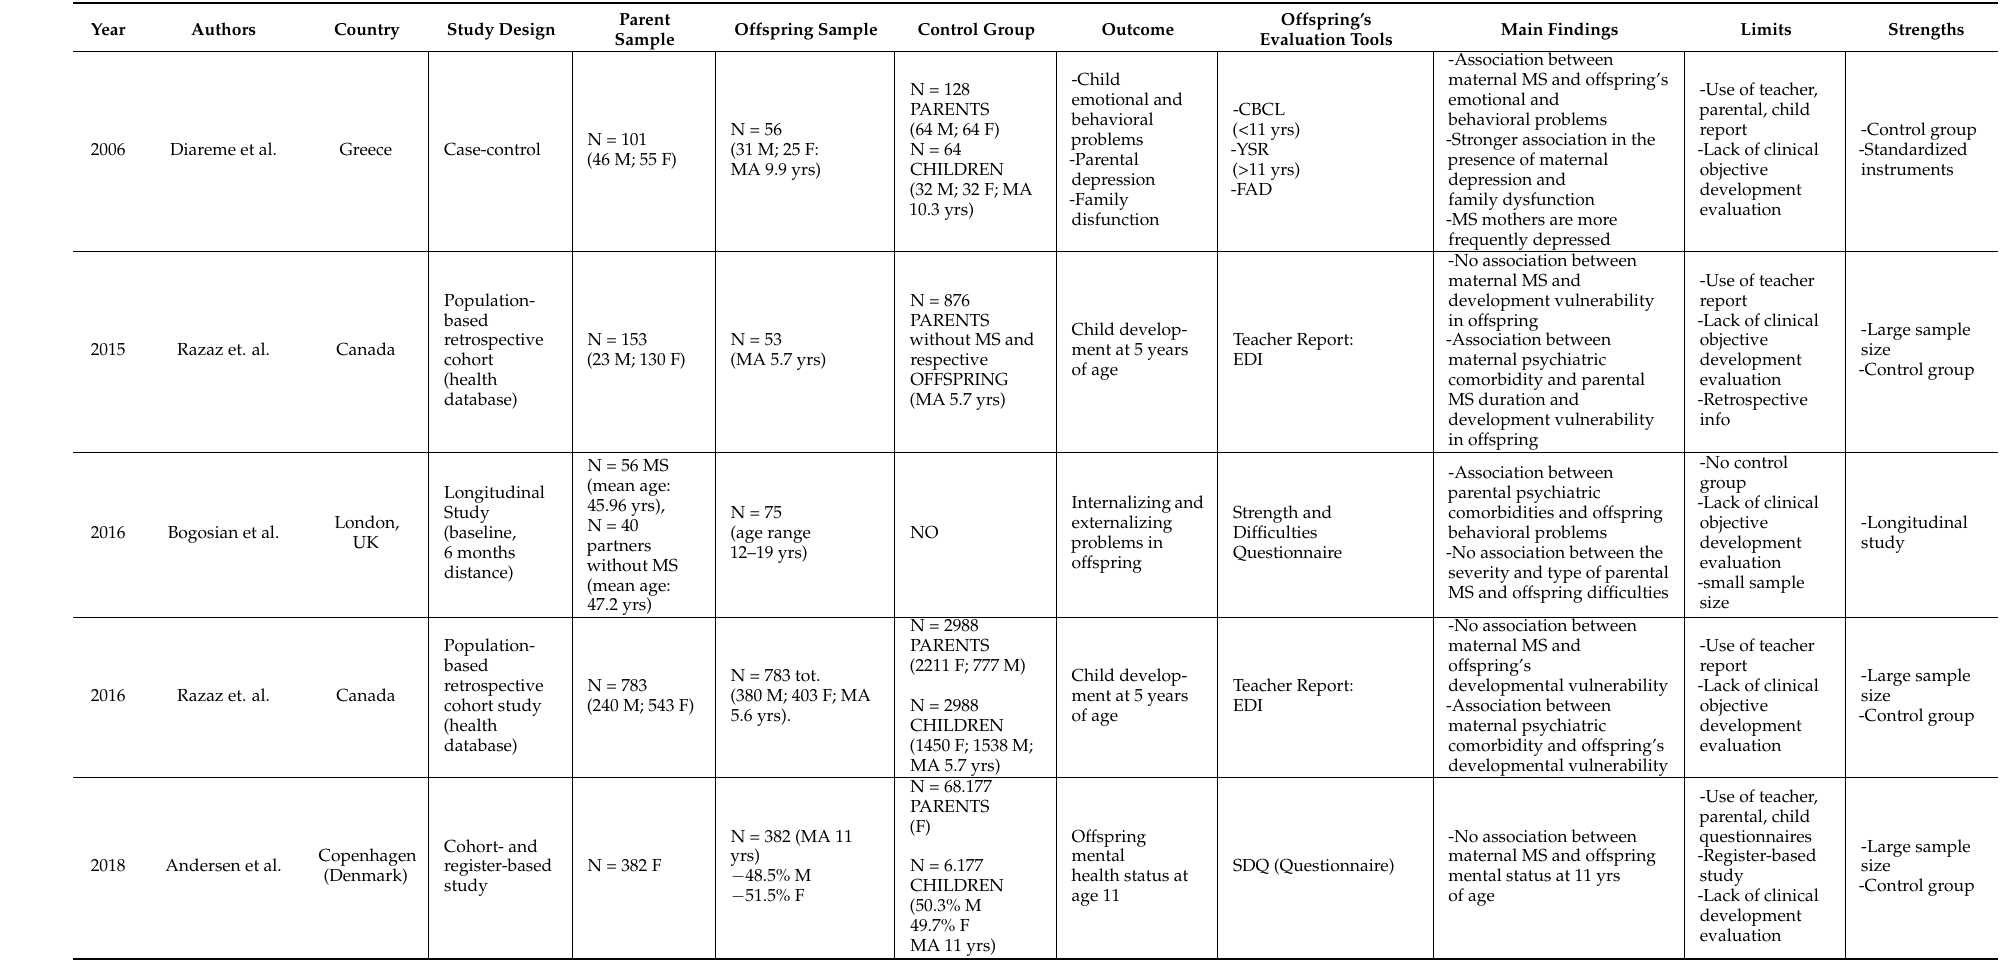
Table 2. Summary of studies measuring offspring’s cognitive/behavioral outcomes within parents with Multiple